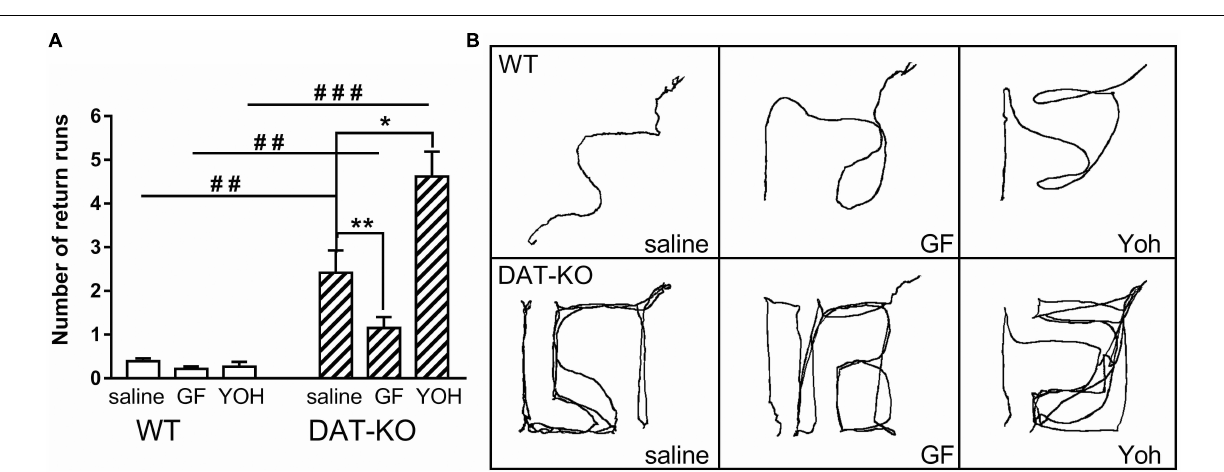
maze exploration during reinforcement searching ( Figure 4B